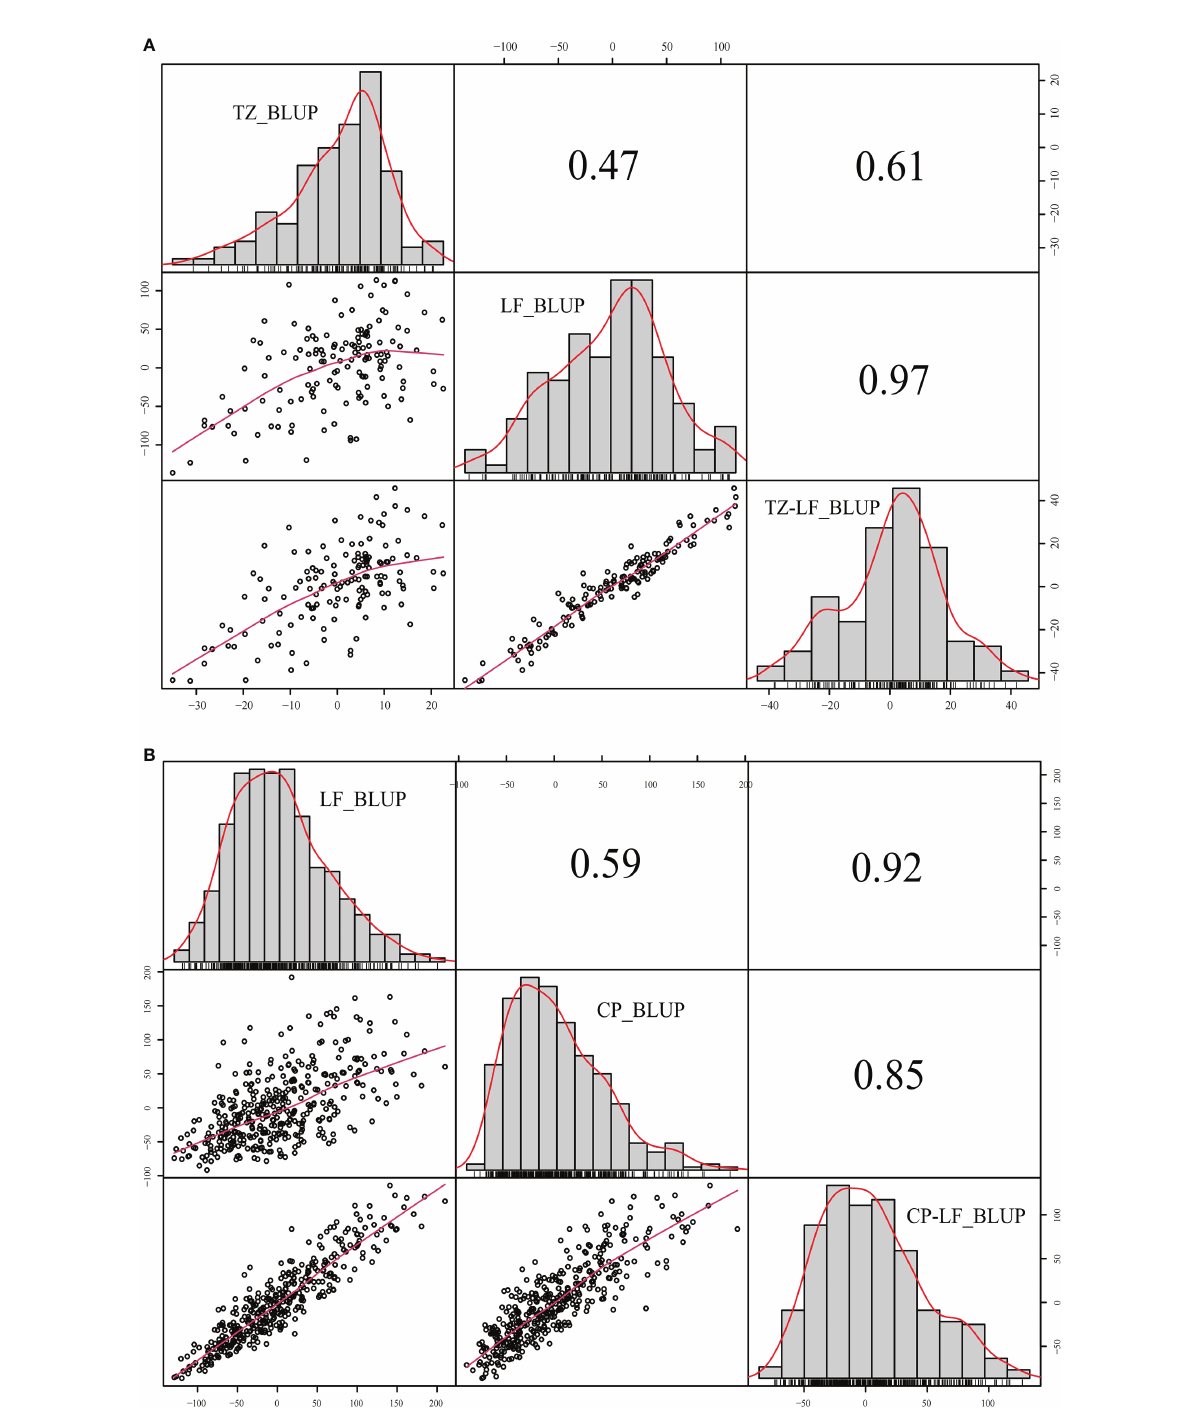
FIGURE 5 Correlation analysis of different locations in the P149 and P392 populations. (A) BLUP was calculated based on locations in the P149 population. (B) BLUP was calculated based on locations in the P392 population. Abbreviation: BLUP, best linear unbiased